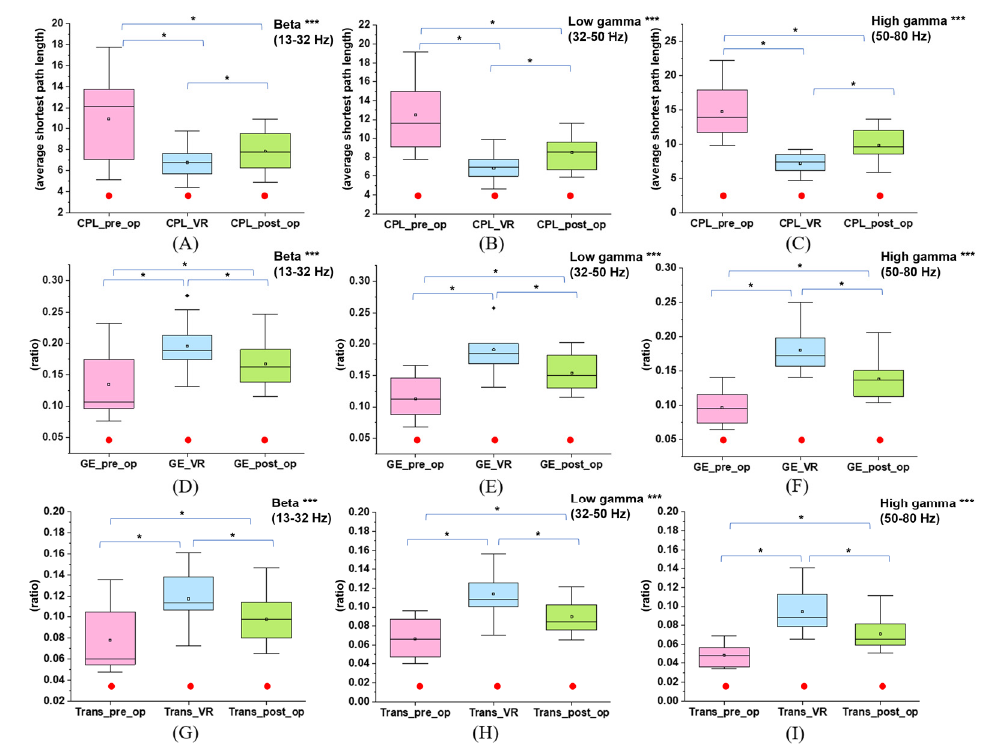
Figure 6. CPL, GE, and transitivity variations in stages one, three, and four at different frequency bands: ( A ) CPL in the beta band ( p < 0.001); ( B ) CPL in the low gamma band ( p < 0.001); ( C ) CPL in the high gamma band (p < 0.001); ( D ) GE in the beta band ( p < 0.001); ( E ) GE in the low gamma band ( p < 0.001); ( F ) GE in the high gamma band ( p < 0.001); ( G ) Transitivity in the beta band ( p < 0.001); ( H ) Transitivity in the low gamma band ( p < 0.001); ( I ) Transitivity in the high gamma band ( p < 0.001). *** indicates that the difference in the diagram is significant ( p < 0.05) in the one-way repeated measures ANOVA, and * indicates that the difference between the sub–paired samples is significant ( p < 0.016) in the post-hoc t -test. The solid red circle indicates no gender difference for this parameter in this